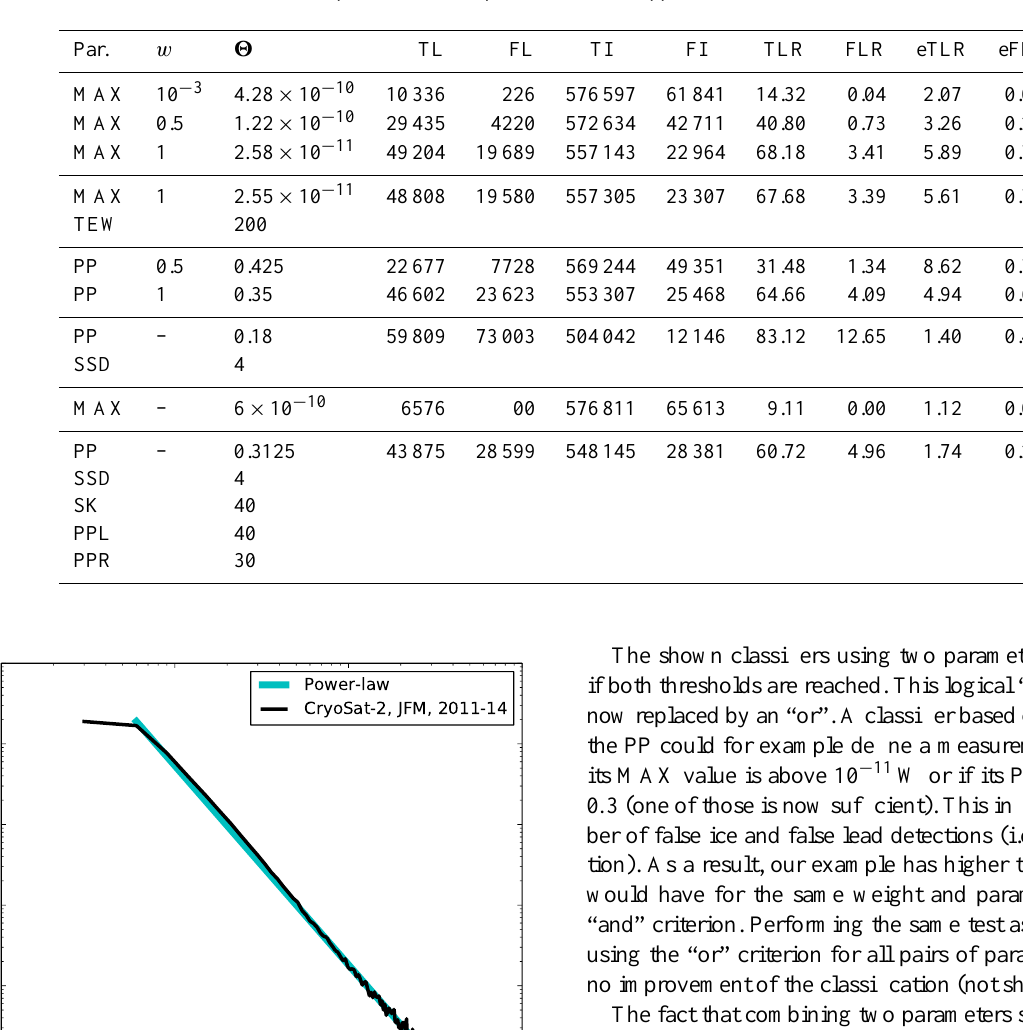
Table 1. Selected classifier performance. The last three classifiers are (from bottom to top): RI14, from Röhrs et al. (2012) and LX13. TL: true leads; FL: false leads; TI: true ice; FI: false ice; TLR and FLR: true and false lead rates (%); eTLR and eFLR: SDs of TLR and FLR within runs (%). A list of all tested classifier performances is provided in the Supplement.